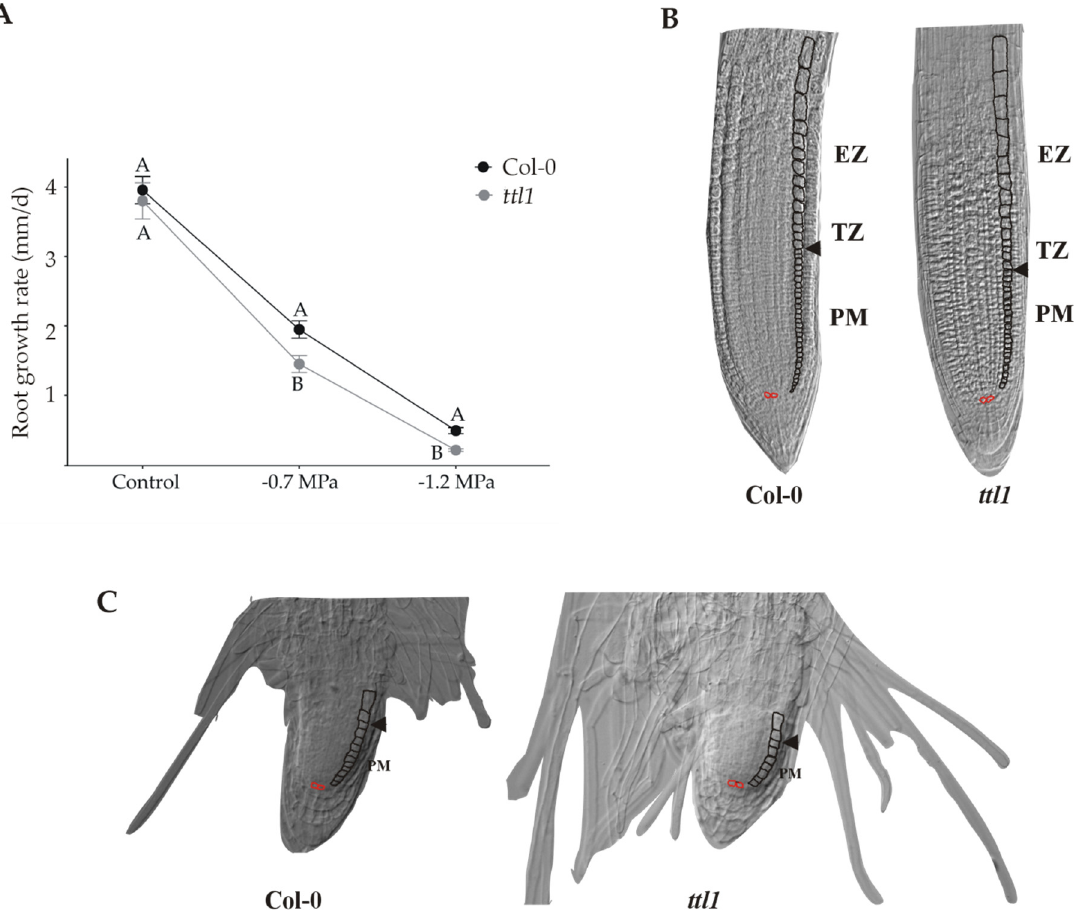
Figure 1. The ttl1 mutant exhibits greater reduction of root growth rate than Col-0 in response to increasing osmotic potential. ( A ) The graphic shows the root growth rate for Col-0 and ttl1 grown during 10 and 7 days in control and stressing − 0.7 MPa and − 1.2Mpa conditions, respectively. The magnitude of deceleration is higher in ttl1 . Different letters indicate statistically significant differences (t Student p < 0.001; n = 30). ( B ) Images of the root apical meristem of Col-0 and ttl1 mutant grown in control conditions. ( C ) Images of the root apical meristem of Col-0 and ttl1 mutant after 7 days of growth in severe osmotic stress conditions ( − 1.2 MPa osmotic potential), showing the reduction in the number of cells in the proximal meristem (PM) and the reduction of the elongation zone (EZ) size. The root length is dependent on the balance between the rate of cell division and cell elongation. Usually, a high number of cells dividing at the RAM produces more cells that can elongate and differentiate, resulting in a high root growth rate [43]. Growth parame- ters affecting the root growth rate were determined in the cortical cell files from the stem cell initials near the quiescent center to the beginning of the differentiation zone in roots exposed to 7 days of osmotic stress [38,39]. Although the number of cortical cells in the PM was reduced in both genotypes in response to increasing osmotic potential, the effect was different in Col-0 and ttl1 . The number of cells in the PM in Col-0 was reduced by 30% after growing for 7 days at − 0.7 MPa of osmotic potential and by 72% after 7 days at − 1.2 MPa. However, the response of the ttl1 mutant was more severe in both osmotic stress conditions: ttl1 had a reduction of the cell number by 42% at − 0.7 MPa and by 79% at − 1.2 MPa compared to Col-0 PM in control conditions (Figure 2).